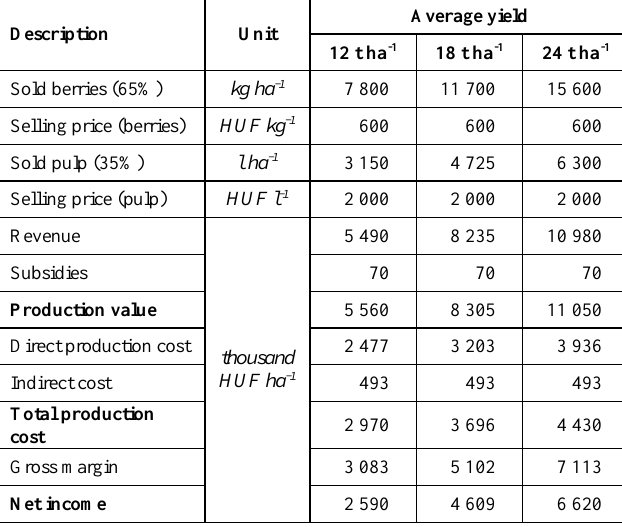
Table 5. Yearly production value and income at farm level in the case